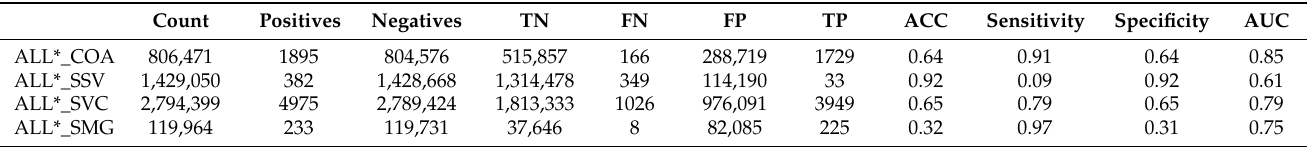
Table 4. Validation results (confusion matrices) for the ALL*